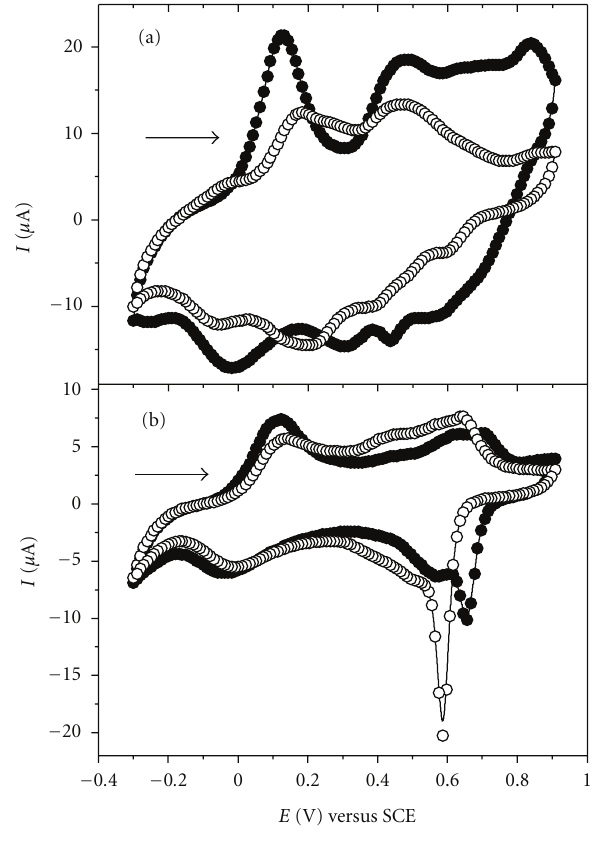
Figure 4: Cyclic voltammograms for LbL films from (a) (PANI- PA/PVS) 6 and (b) (PANI-PA/CG) 6 after five and twenty (5th cycle — (cid:2) — and 20th cycle — (cid:4) —) successive cycles in 0.1 molL − 1 HCl solution, at 50 mVs − 1